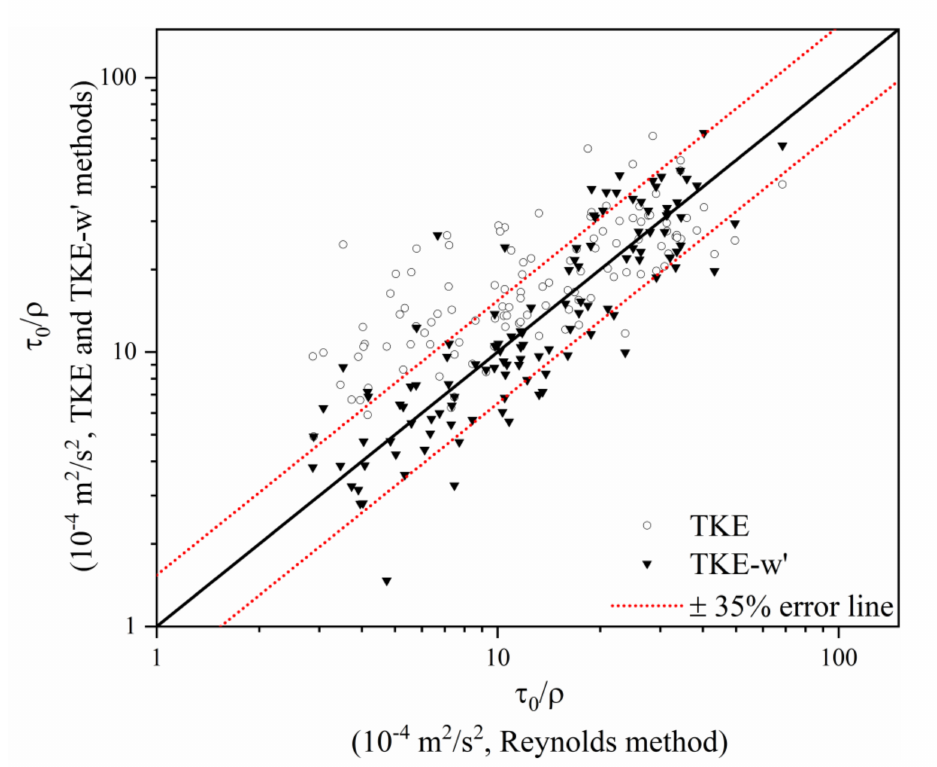
Figure 7. Comparison of Reynolds method with the TKE and TKE-w (cid:48) methods after re-estimation of